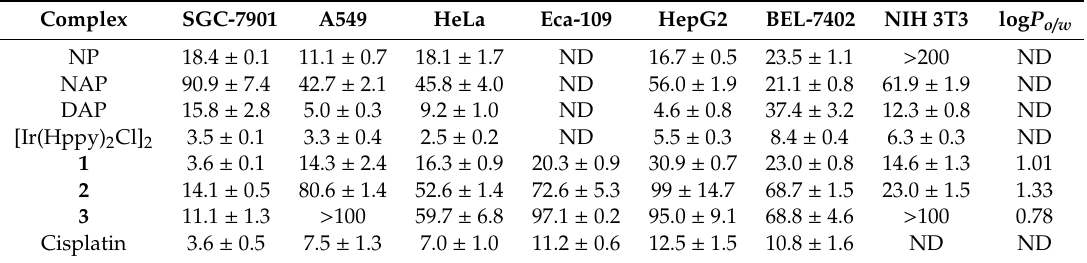
Table 1. IC 50 ( µ M) values of the complexes toward the selected cancer cell lines for 48 h and log P o / w .